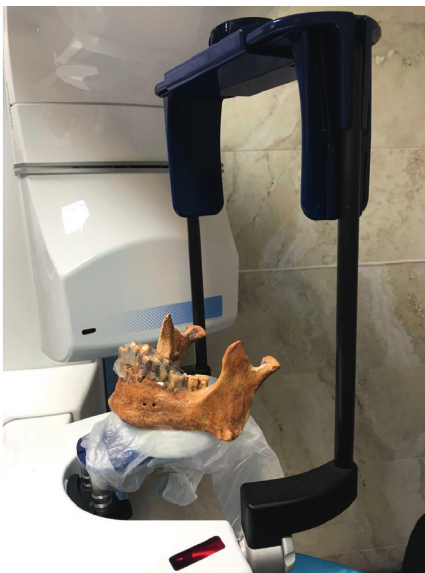
Figure 1: Teeth mounted on a dried mandible bone in the CBCT